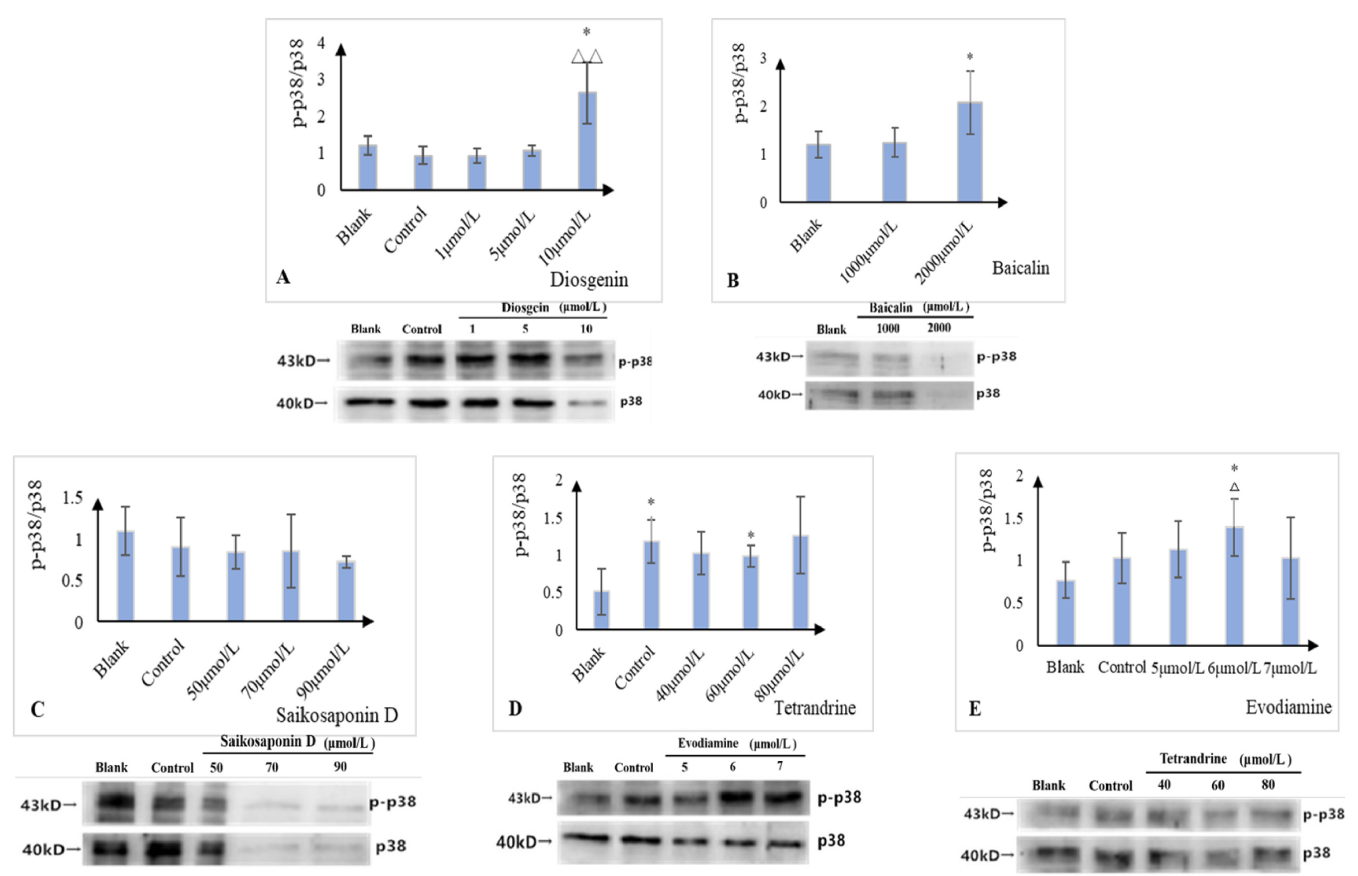
Fig 6. Effect of potential liver injury components on the expression of p38